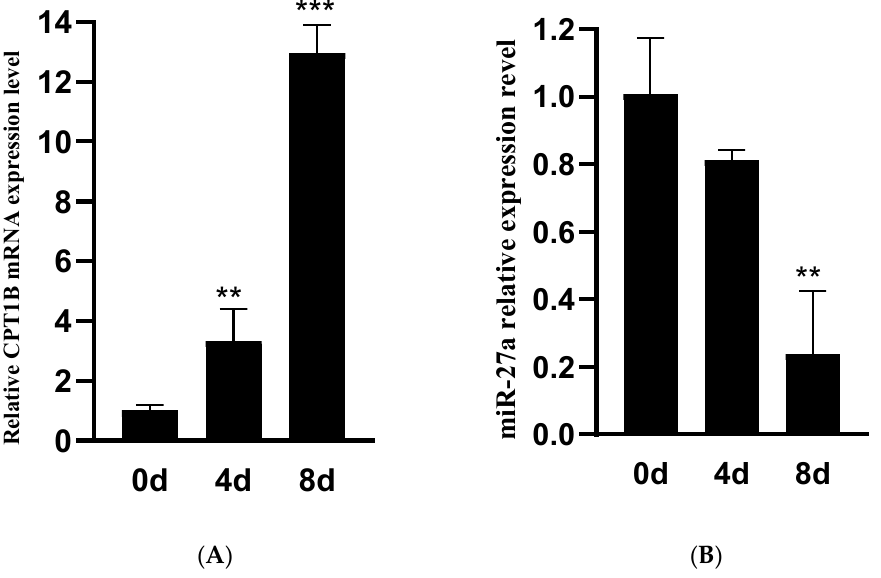
Figure 1. Temporal expression pattern of miR-27a and CPT1B under ovine preadipocytes differen- tiation. Ovine preadipocytes were submitted to induced differentiation for eight days. Cells were collected on days 0, 4, and 8, and expression of CPT1B ( A ) and miR-27a ( B ) was determined by RT-PCR. ** p < 0.01, *** p < 0.001.